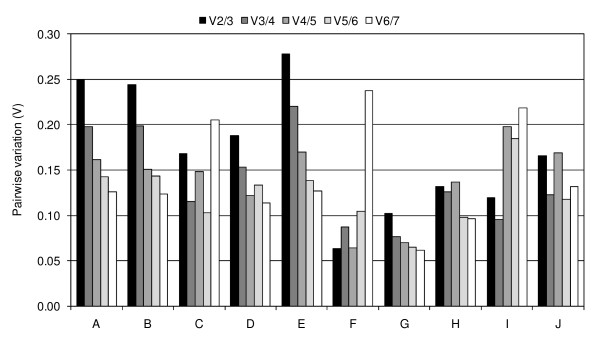
Pairwise variation (V) to determine the optimal number of reference genes for accurate normalisation. (A) all 442 perennial ryegrass tissue samples, (B) 422 field-grown samples harvested following different defoliation management, (C) 13 laboratory-grown samples, (D) 218 perennial ryegrass stubble samples, (E) 220 perennial ryegrass leaf samples, (F) four perennial ryegrass callus, inflorescence and root samples, (G) five perennial ryegrass etiolated seedlings of different cultivars, (H) four field-grown samples harvested at the peak of each season, (I) three laboratory-grown samples to evaluate water stress and (J) four laboratory-grown samples to evaluate cold stress.